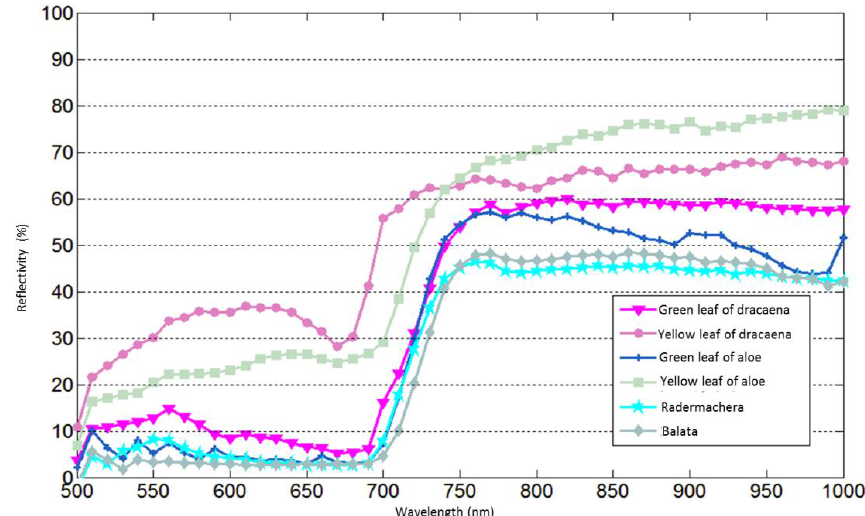
Figure 7. Hyperspectral Lidar derived spectral profiles of 6 leaves from 4 plant species (dracaena, aloe, balata, and radermachera).